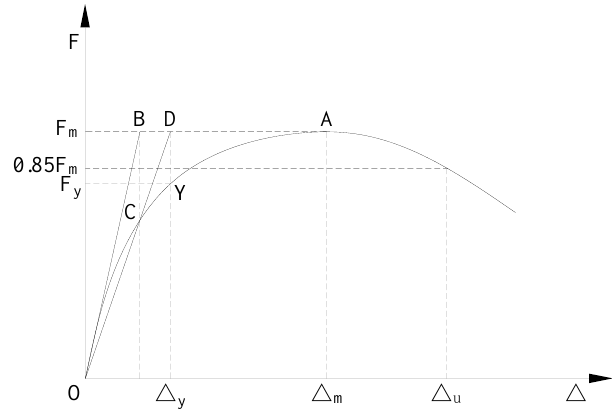
Figure 11. Geometric mapping method.